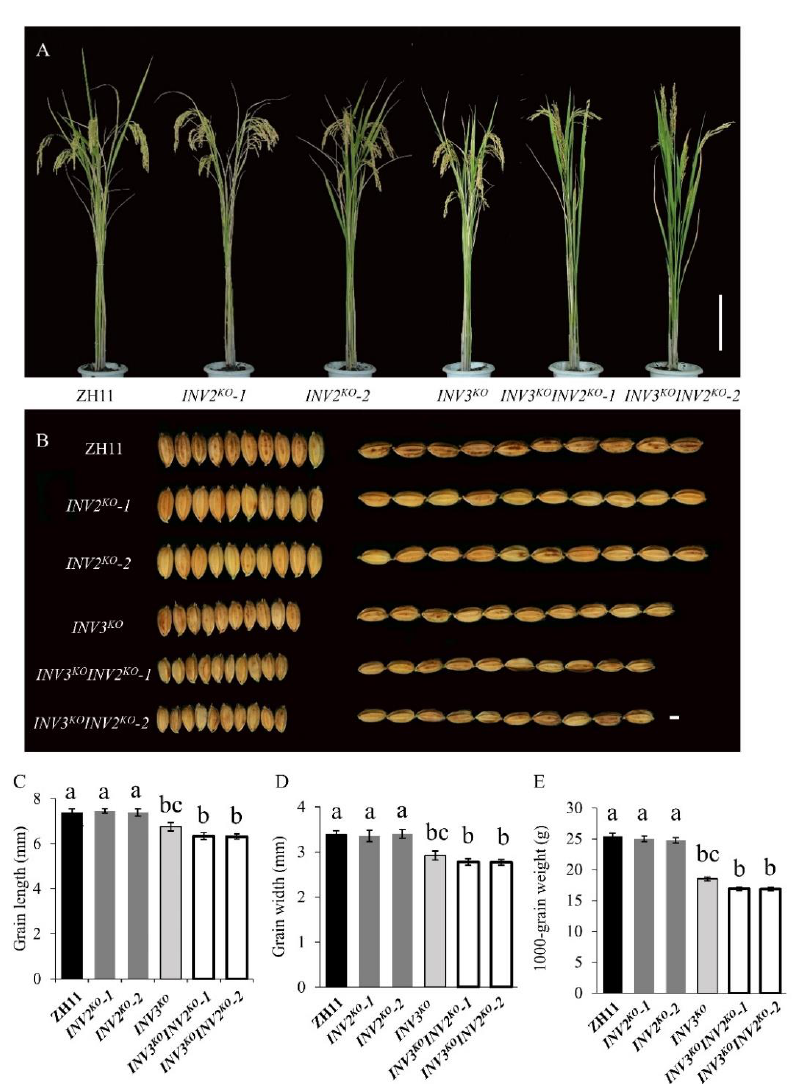
Figure 9. Genetic interactions of INV2 and INV3 . ( A ) Plant comparison of ZH11, INV2 KO -1 , INV2 KO -2 , INV3 KO , INV3 KO INV2 KO -1, and INV3 KO INV2 KO -2 at maturity stage. Bar = 25 cm. ( B ) Morphology of grain shape in ZH11, INV2 KO -1 , INV2 KO -2 , INV3 KO , INV3 KO INV2 KO -1, and INV3 KO INV2 KO -2 . Bar = 2 mm. ( C – E ) Statistical data of the grain length ( C ), grain width ( D ), 1000-grain weight ( E ) in ZH11, INV2 KO -1 , INV2 KO -2 , INV3 KO , INV3 KO INV2 KO -1, and INV3 KO INV2 KO -2 . Data are given as means ± SD. Different letters indicate statistically significant differences at the p = 0.01 level by Student’s t-test. Table 3. Agronomic traits of ZH11 and KOs .